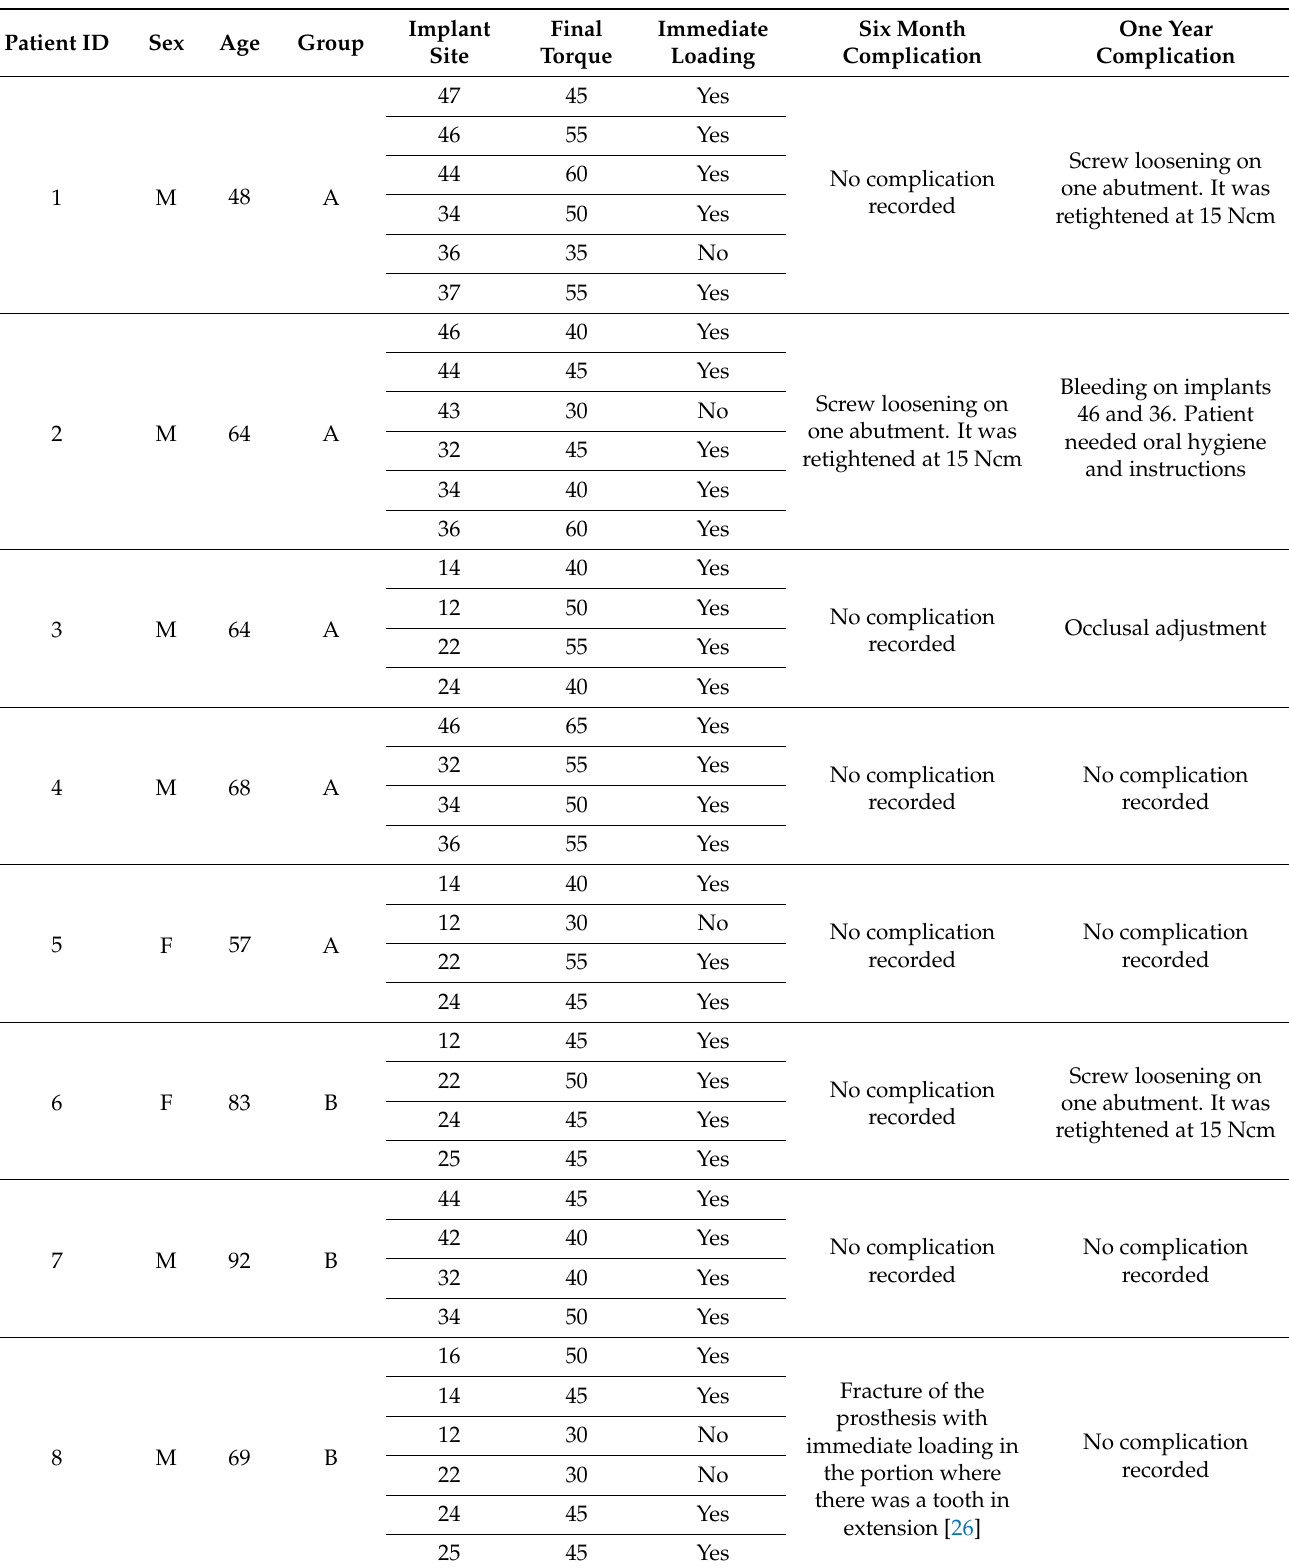
Table 1. The table shows the main data of the treated patients. It also shows the main complications during surgical and prosthetic